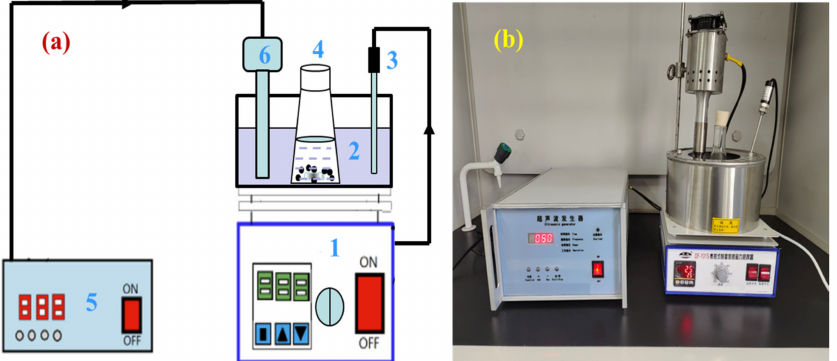
Figure 4. Experimental apparatus for ultrasound leaching: ( a ) schematic diagram; and ( b ) device diagram. In ( a ), 1—heat collection type thermostatic bath; 2—water bath; 3—thermometer, 4—conical flask; 5—ultrasonic generator; 6—ultrasonic probe.